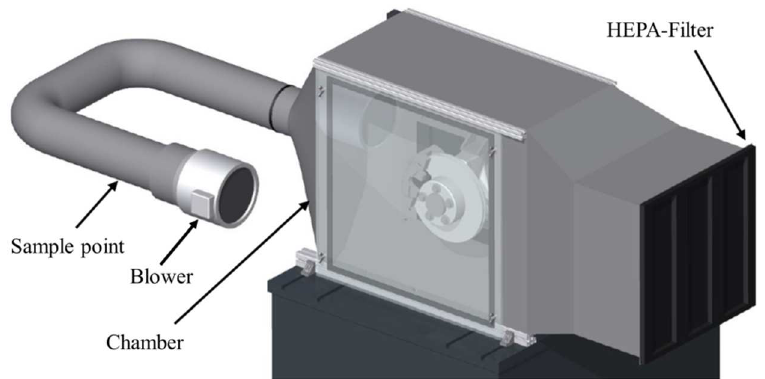
Figure 1. TU Ilmenau constant volume sampling system (CVS).